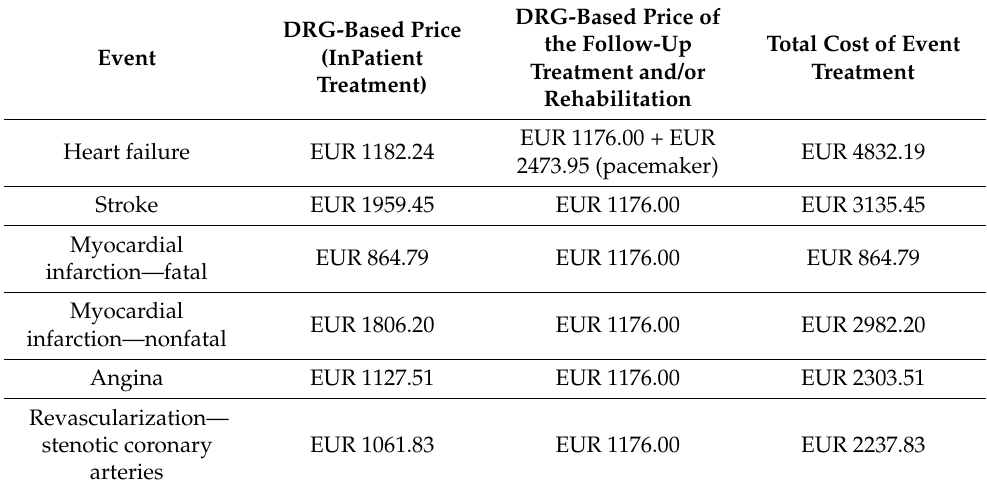
Table 6. DRG prices for the treatment of unwanted clinical events (costing catalogue of CHIF). DRG-Based Price Event